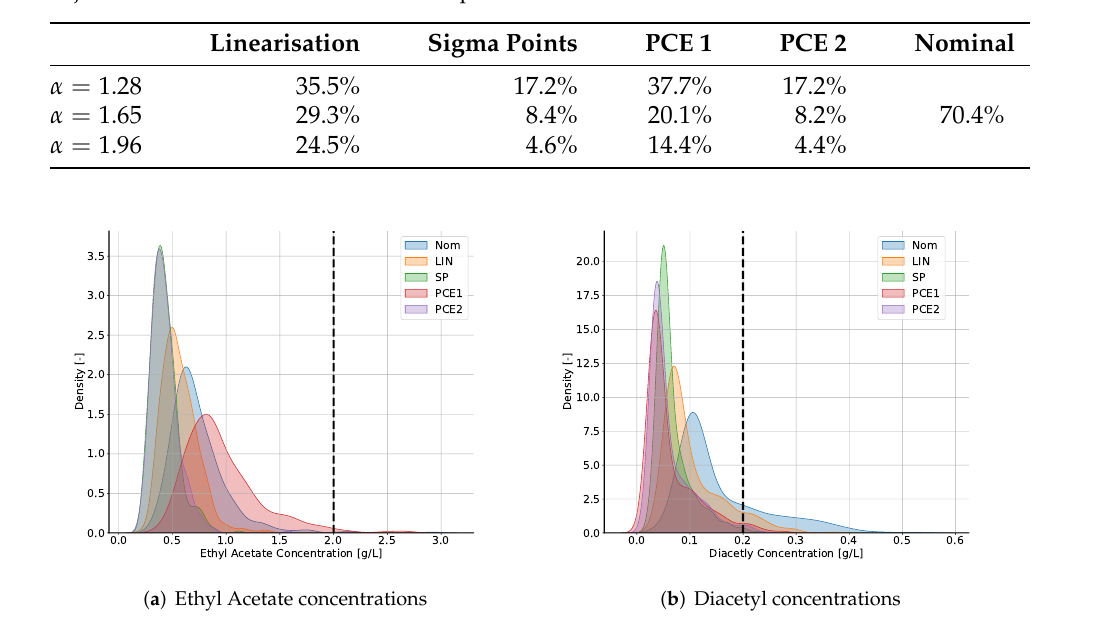
Table 5. Constraint violations obtained from Monte Carlo simulations for the minimising time objective via all the methods and backoff parameter values.